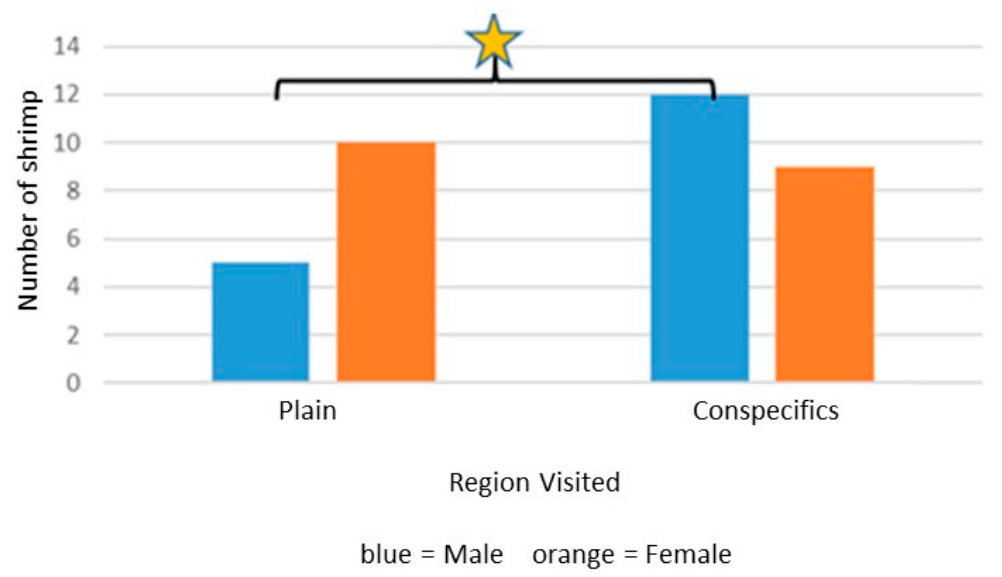
Figure 9. Initial choice in the Y-maze for the shrimp Latreutes fucorum between arm with the chemical cue vs. the arm with plain seawater in conspecific chemical cue trials based on sex (binomial test; males, p = 0.05; females, p = 0.18). Star/bracket indicates significant differences between indicated paired groups.